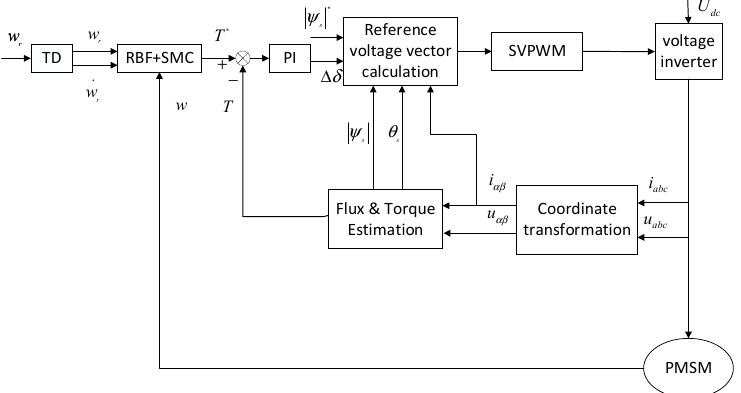
Table 1. The parameters of the PMSM. Figure 4. Block diagram of PMSM control system with TD and RBF-SMC speed controller. The parameters of PMSM are shown in Table 1. The Parameter